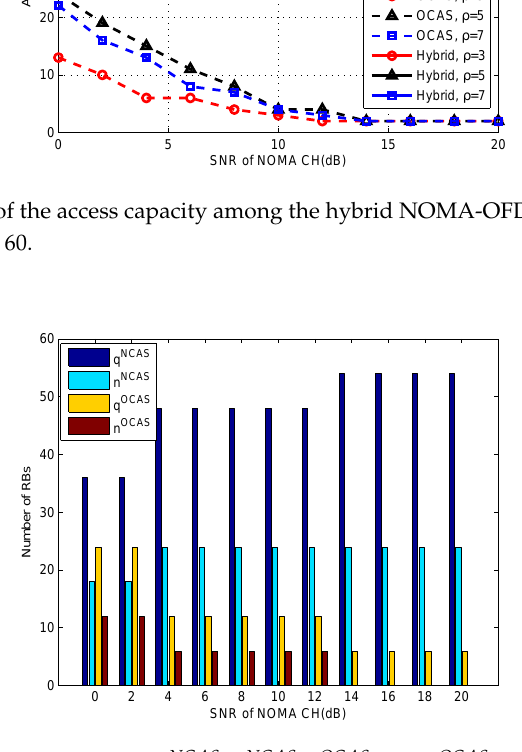
Figure 8. Comparison among q NCAS , n NCAS , q OCAS , and n OCAS , ρ = 5 dB, U =